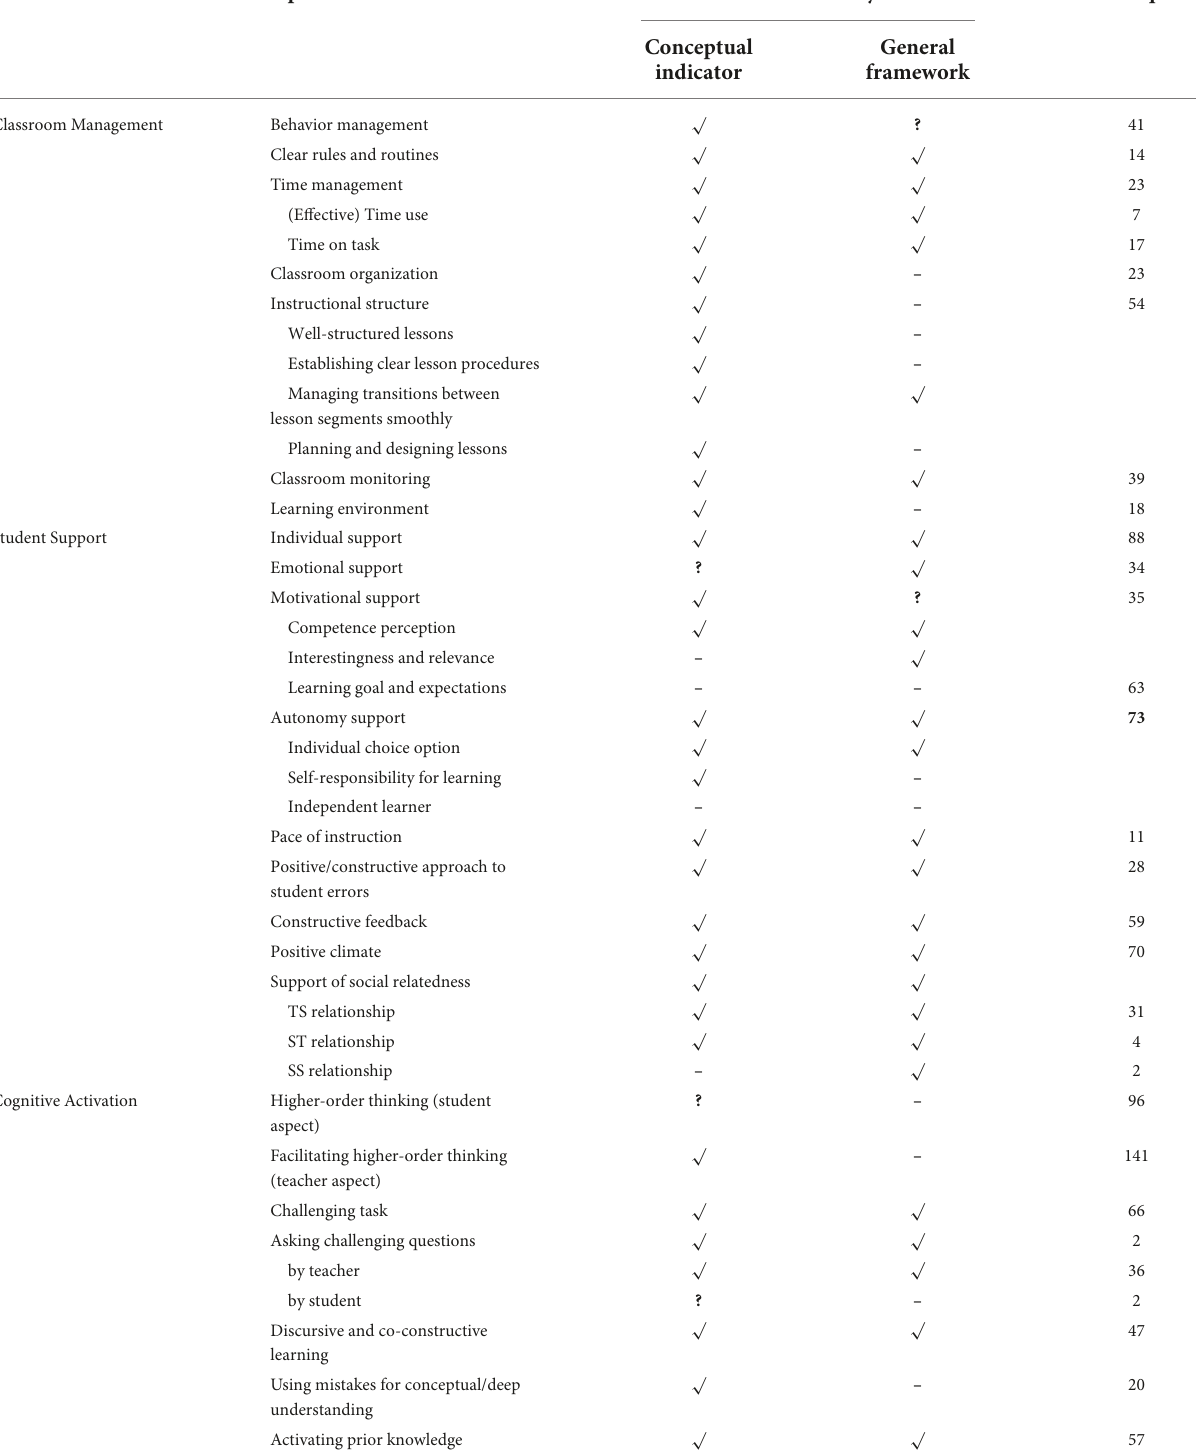
TABLE 2 Frequency table of the identified operational indicators (Inductive Coding). Core factors If described by